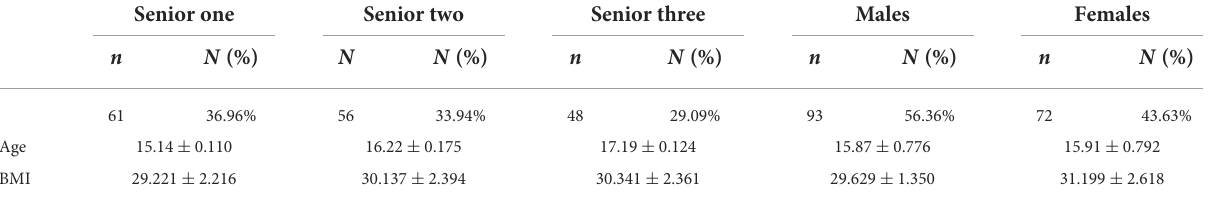
TABLE 1 Basic information on obese students ( n =